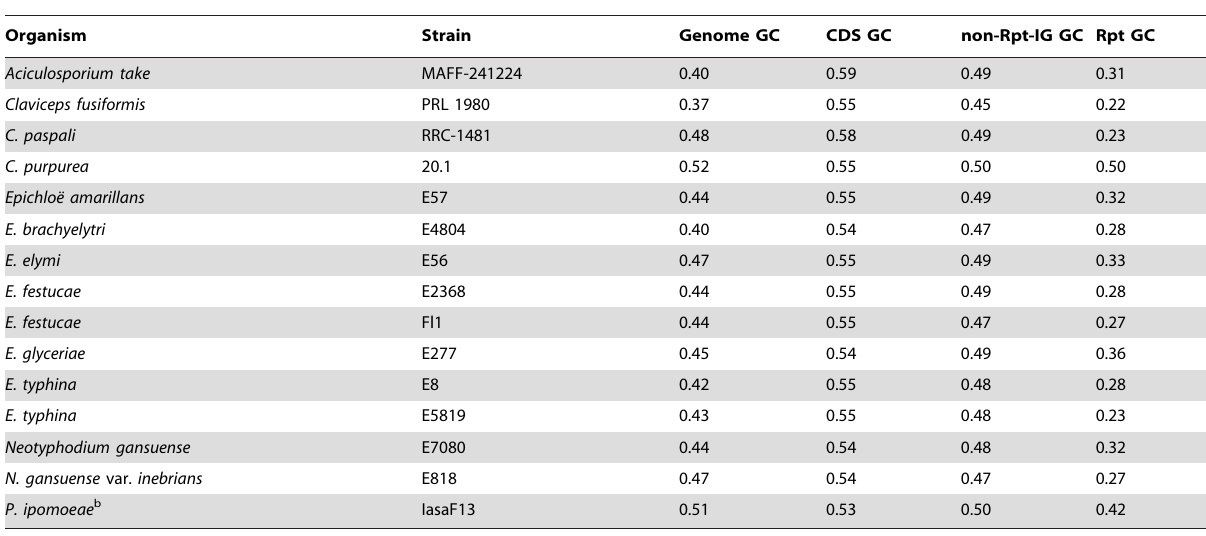
Table 3. GC proportions in genic and repeat DNA of sequenced genomes.